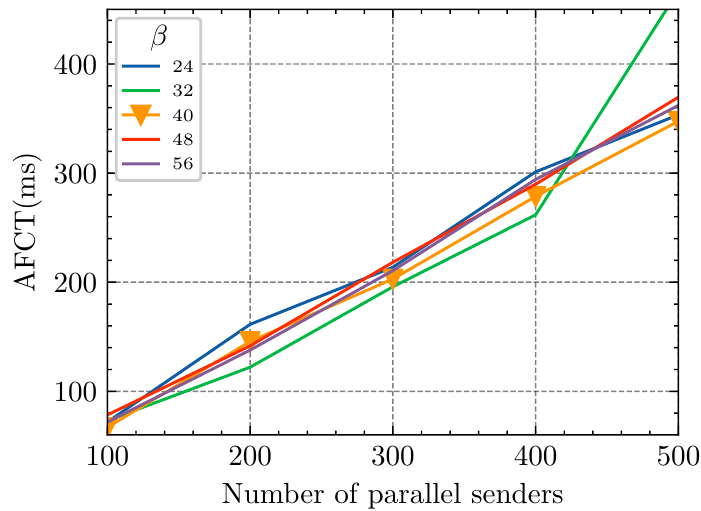
Figure 6. AFCT for short flows with different initial β values.